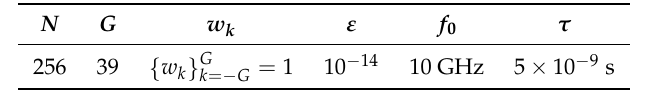
Table 5. Simulation parameters for the second